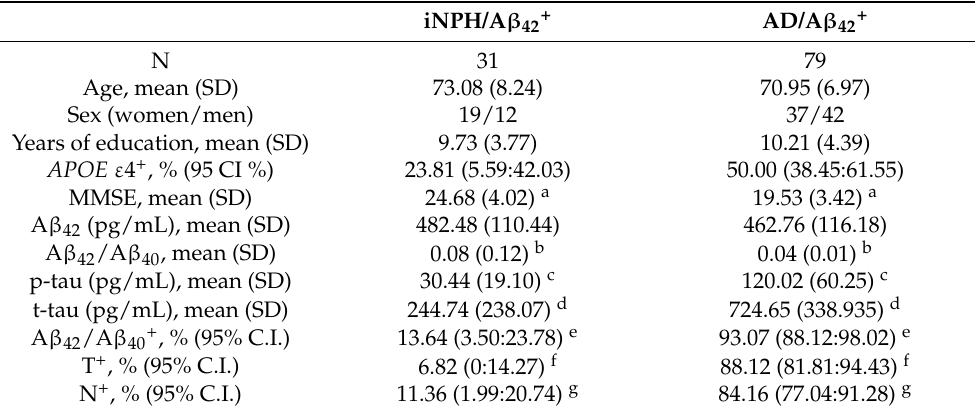
Table 4. Comparison of demographic variables and CSF biomarker values between iNPH/A β 42+ and AD/A β 42+